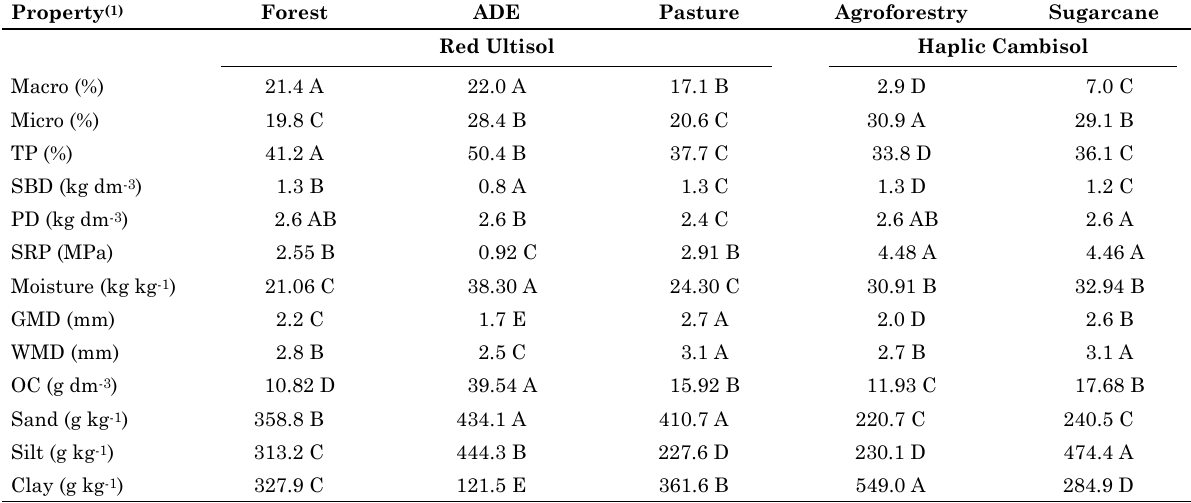
Table 1. Means test of physical properties for the environments evaluated from the municipalities of Humaitá and Manicoré in the south of Amazonas Property (1) Forest ADE Pasture Agroforestry Sugarcane Red Ultisol Haplic